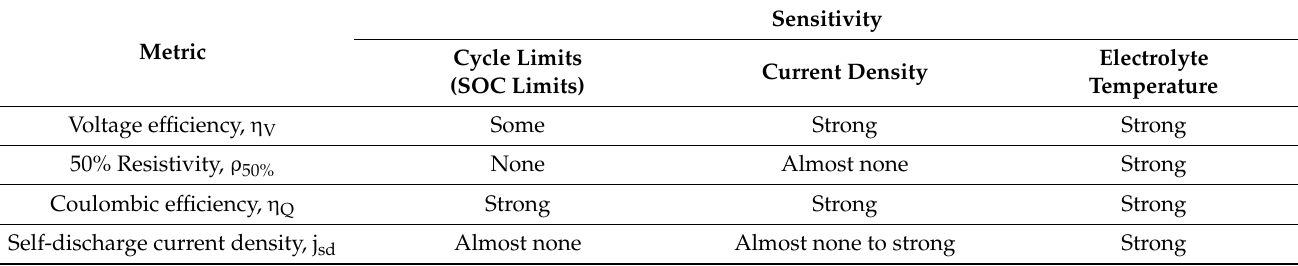
Table 1. Comparison of the sensitivity of the benchmarking metrics outlined